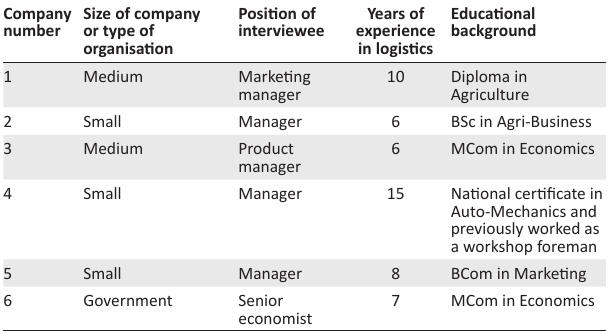
TABLE 1: Small and medium-sized enterprises and interviewee profile. Company Size of company number or type